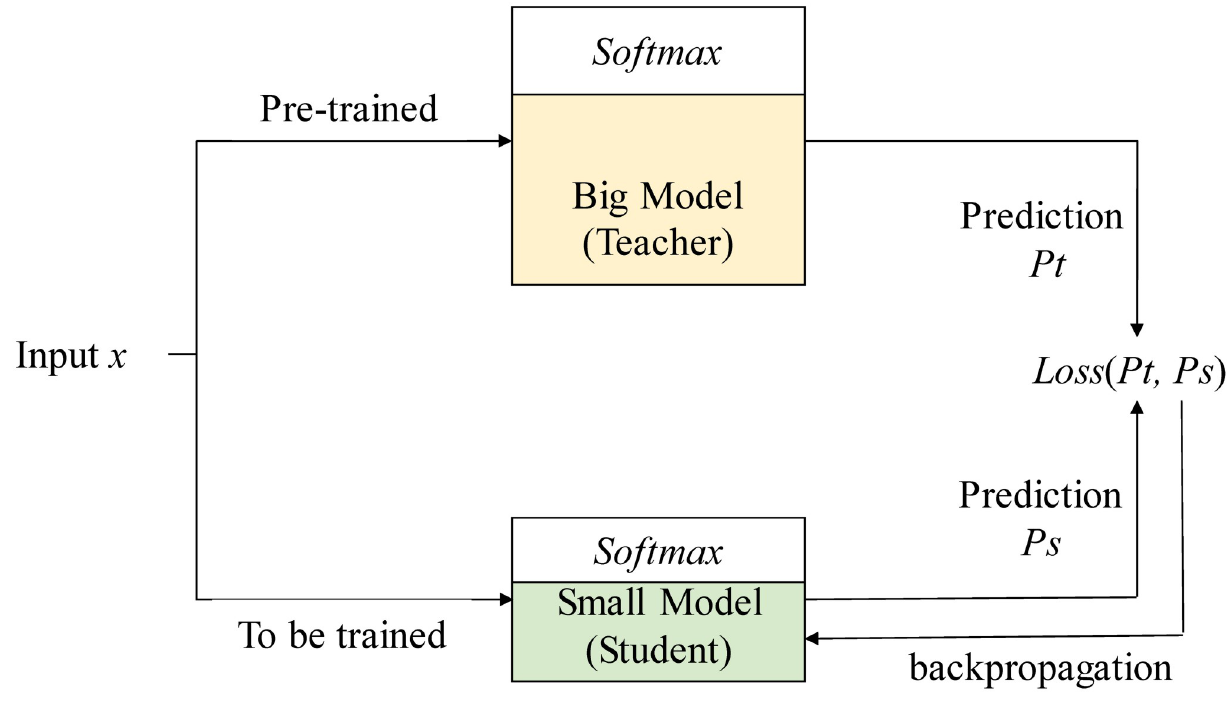
Fig 2. Classic knowledge distillation